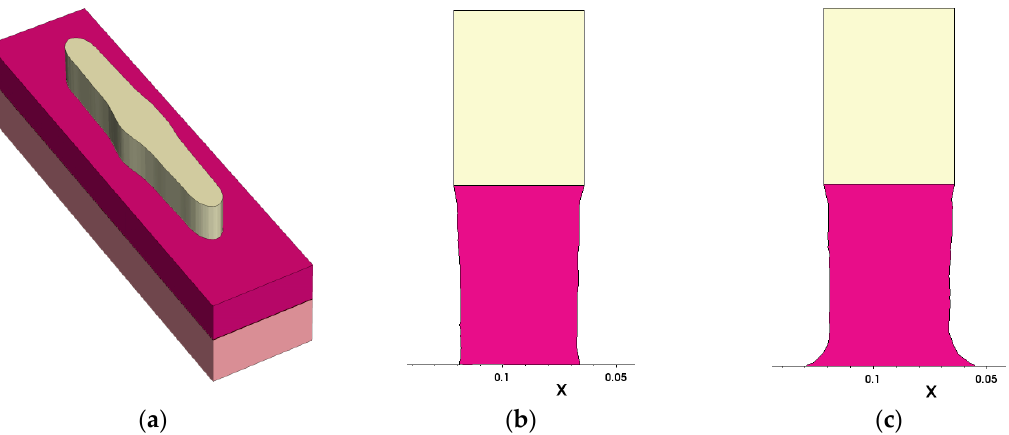
Figure 12. Coupled simulation of lithography and etching: ( a ) 3D simulation of the resist line geometry (yellow) above the polysilicon (purple); ( b ) simulated etched gate electrode for a position close to the center of the wafer (distance to center axis = 0.14 cm); ( c ) Simulated etched gate electrode for a position at the wafer rim (distance to center axis = 9.7 cm). The unit for the x axis in ( b ) and ( c ) is